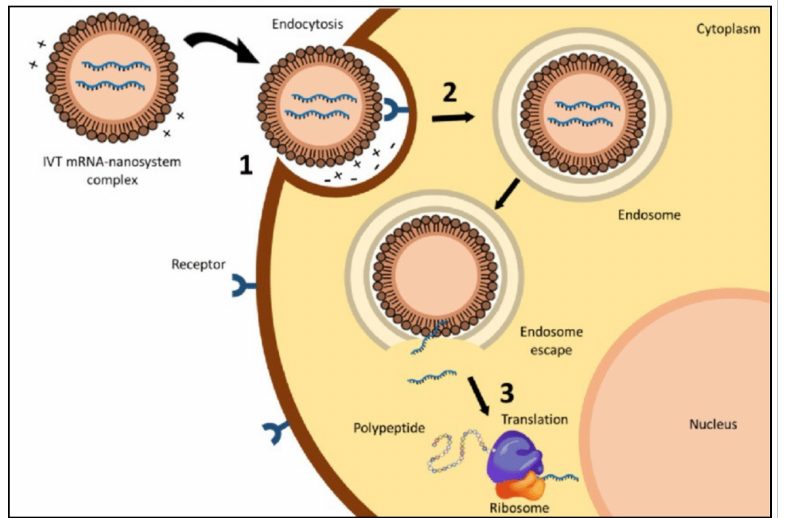
Figure 1. Intracellular barriers for in vitro transcribed (IVT) mRNA delivery: (1) interaction between the delivery system and the cell membrane, (2) endocytosis, and (3) endosomal escape and release of the mRNA to start the translation process (reproduced from Gomez-Aguado et al. [23]).